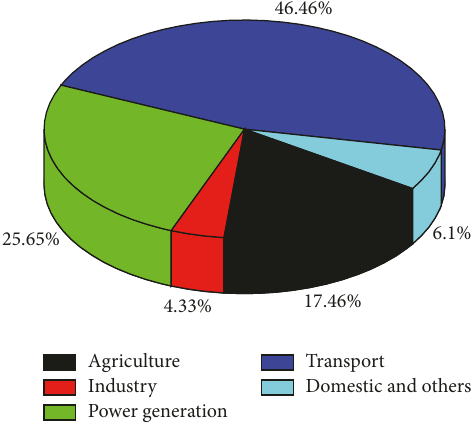
Figure 1: Sector-wise consumption of petroleum fuels in Bangla-